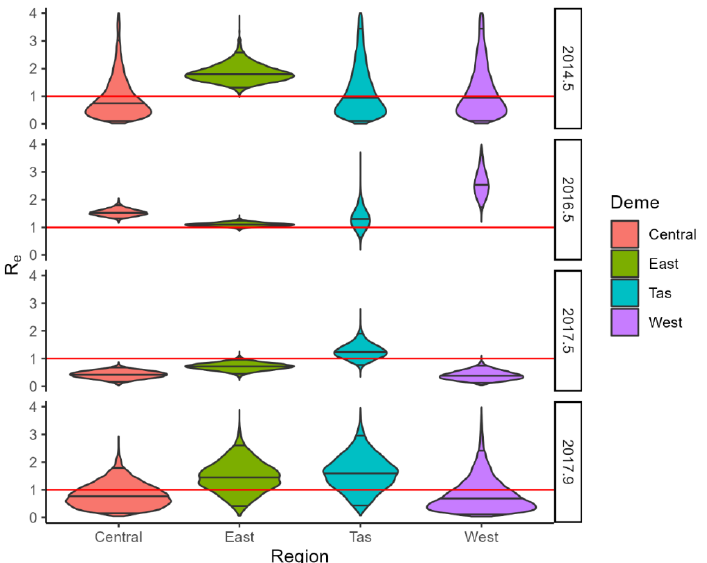
Figure 10. Violin plots of R e densities for RHDV2 in each region (Central, Eastern, Western, and Tasmania) and epoch. Red line marks R e = 1.